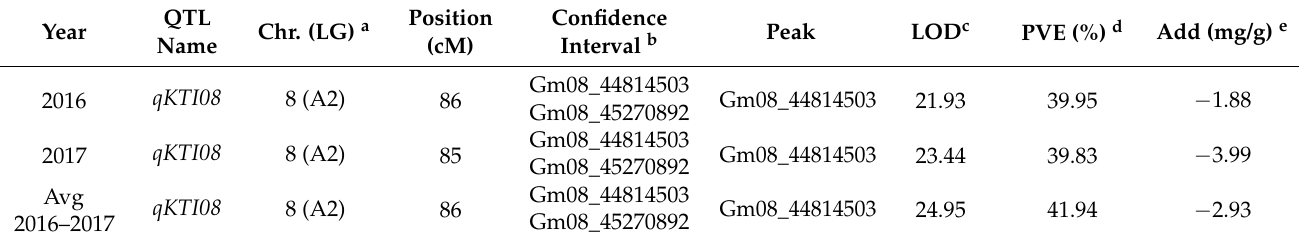
Table 6. Quantitative trait loci (QTL) mapping, marker intervals, logarithm of odds (LOD) scores, percentage of variance (PVE), and additive effects of QTL for KTI concentration (qKTI08) in the F3:5 mapping population derived from Glenn x PI